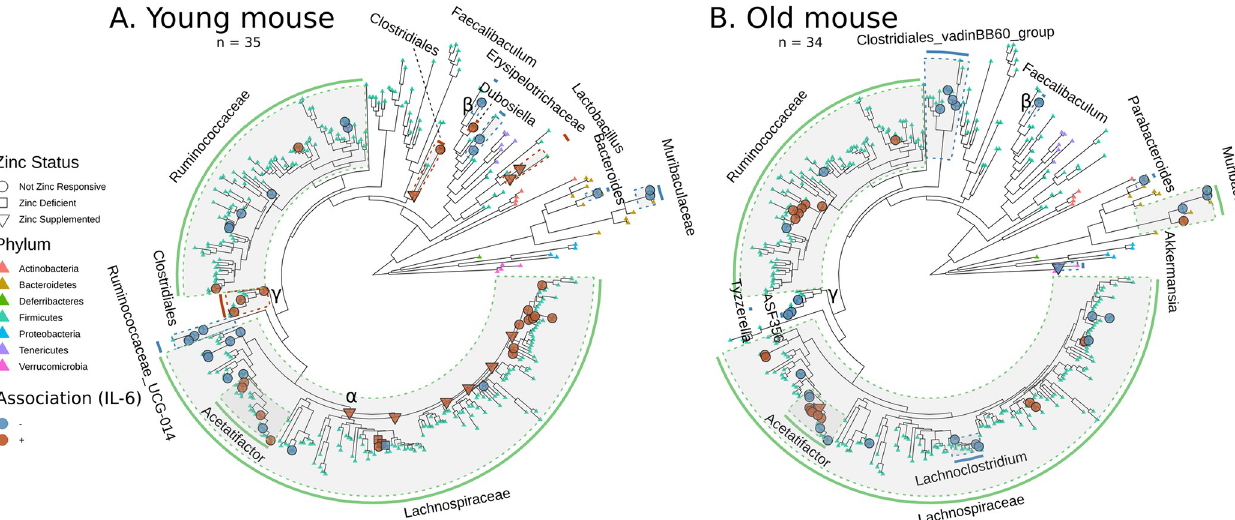
Fig 4. Associations between bacterial cladal abundance and inflammation marker IL-6. The phylogenetic tree (identical for both A and B) is based on alignment of ASVs to a reference 16S alignment. Clades are colored for type of association (blue for negative, orange for positive) with IL-6 for young (A) and old (B) mice, respectively. Nodes are marked with squares, triangles, and circles for overlap with significant associations with zinc deficiency, zinc supplementation, and no overlap, respectively. Shaded clades are marked with the respective shared taxonomic phylotype, and color coded based on association (green indicates variable association within a particular clade). Tree tips are colored based on taxonomic phylum, regardless of association with IL- 6. α indicates the most basal clade of Lachnospiraceae that is negatively correlated with zinc supplementation and positively correlated with IL-6. β indicates a clade of Faecalibaculum that is negatively correlated with IL-6 in both young and old mice. γ indicates the basal node of three clades each that are positively and negatively correlated with young and old mice, respectively. n = 35 young mice fecal samples, n = 34 old mice fecal samples, using only week 6 fecal samples including from both supplementation and deficiency